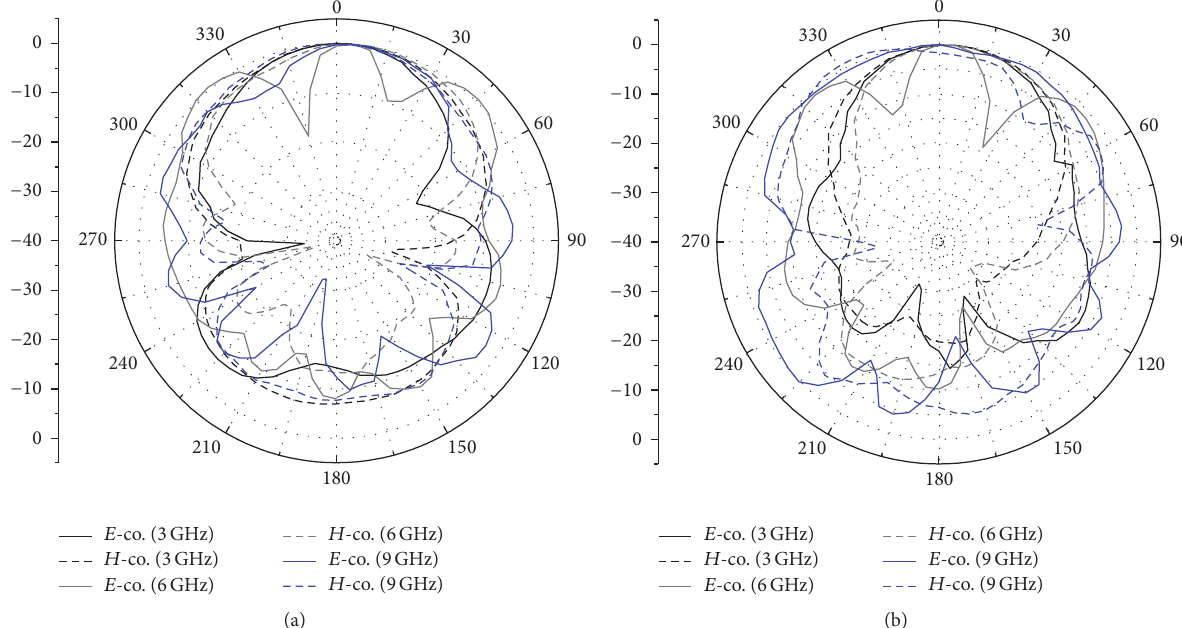
Figure 8: Measured copolarized radiation patterns at three different frequencies: (a) Port 1 is excited and Port 2 is terminated with a 50 Ω load. (b) Port 2 is excited and Port 1 is terminated with a 50 Ω